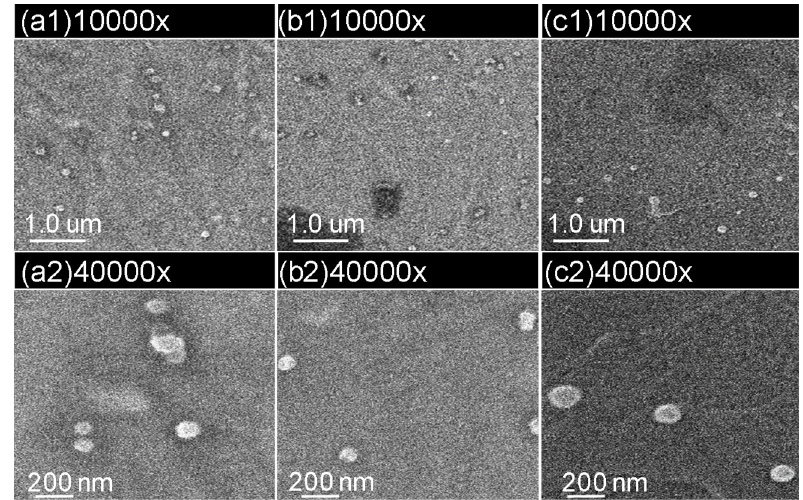
Figure 5. Scanning electron microscopy (SEM) images of micelles prepared from different polymer bottlebrushes ( a ) PVBPA 27 - g -PNVP 4 , ( b ) PVBPA 80 - g -PNVP 120 , and ( c ) PVBPA 34 - g -PNVP 60 .